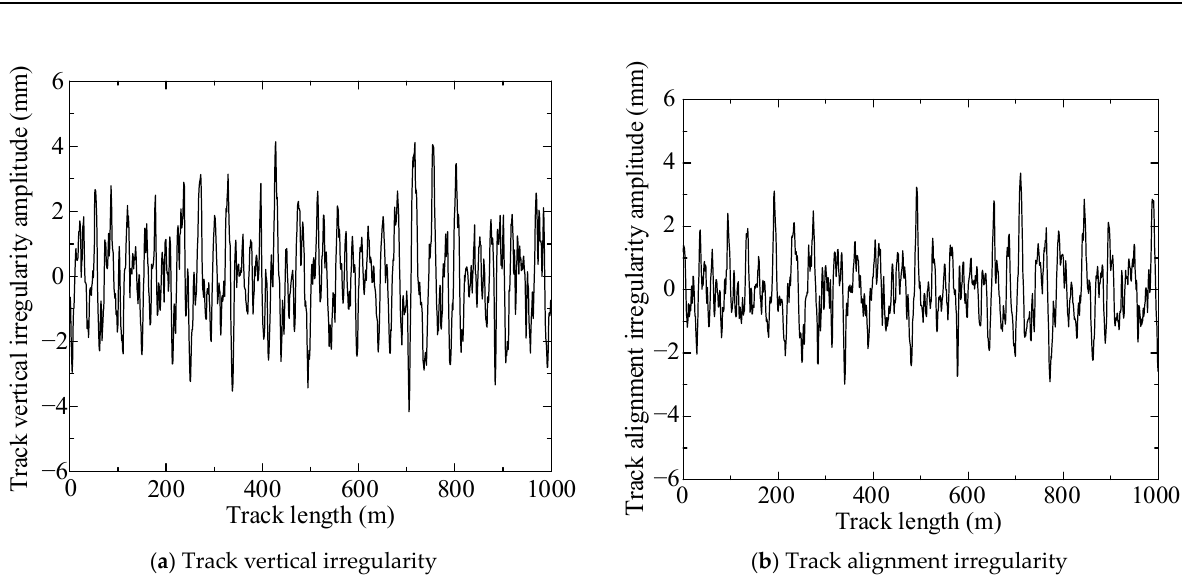
the inverse Fourier transform method. Using the MATLAB platform, the German low- interference track height and track irregularity samples are drawn, as shown in Figure 20. Then, the track component is divided. On this basis, the track surface coordinates are modified by the input file to realize the application of track irregularity. The details of the track model with track irregularity are shown in Figure 21.